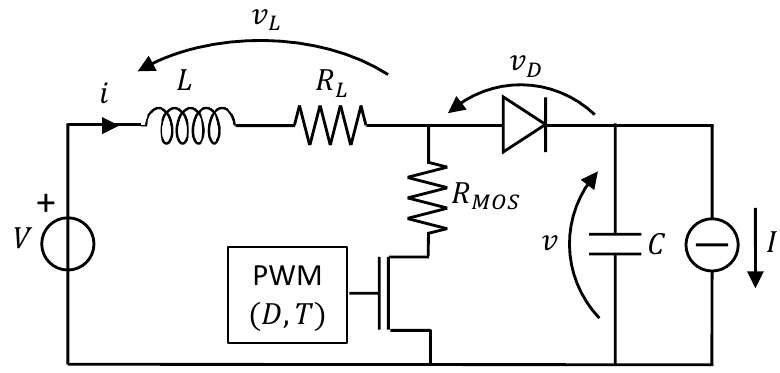
Figure 1. Schematic of a boost